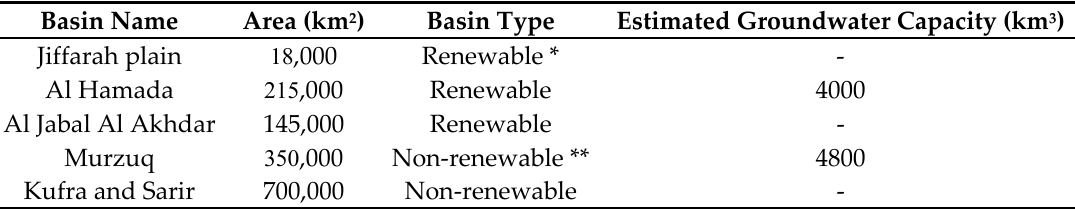
Table 2. The main underground basins and their characteristics in